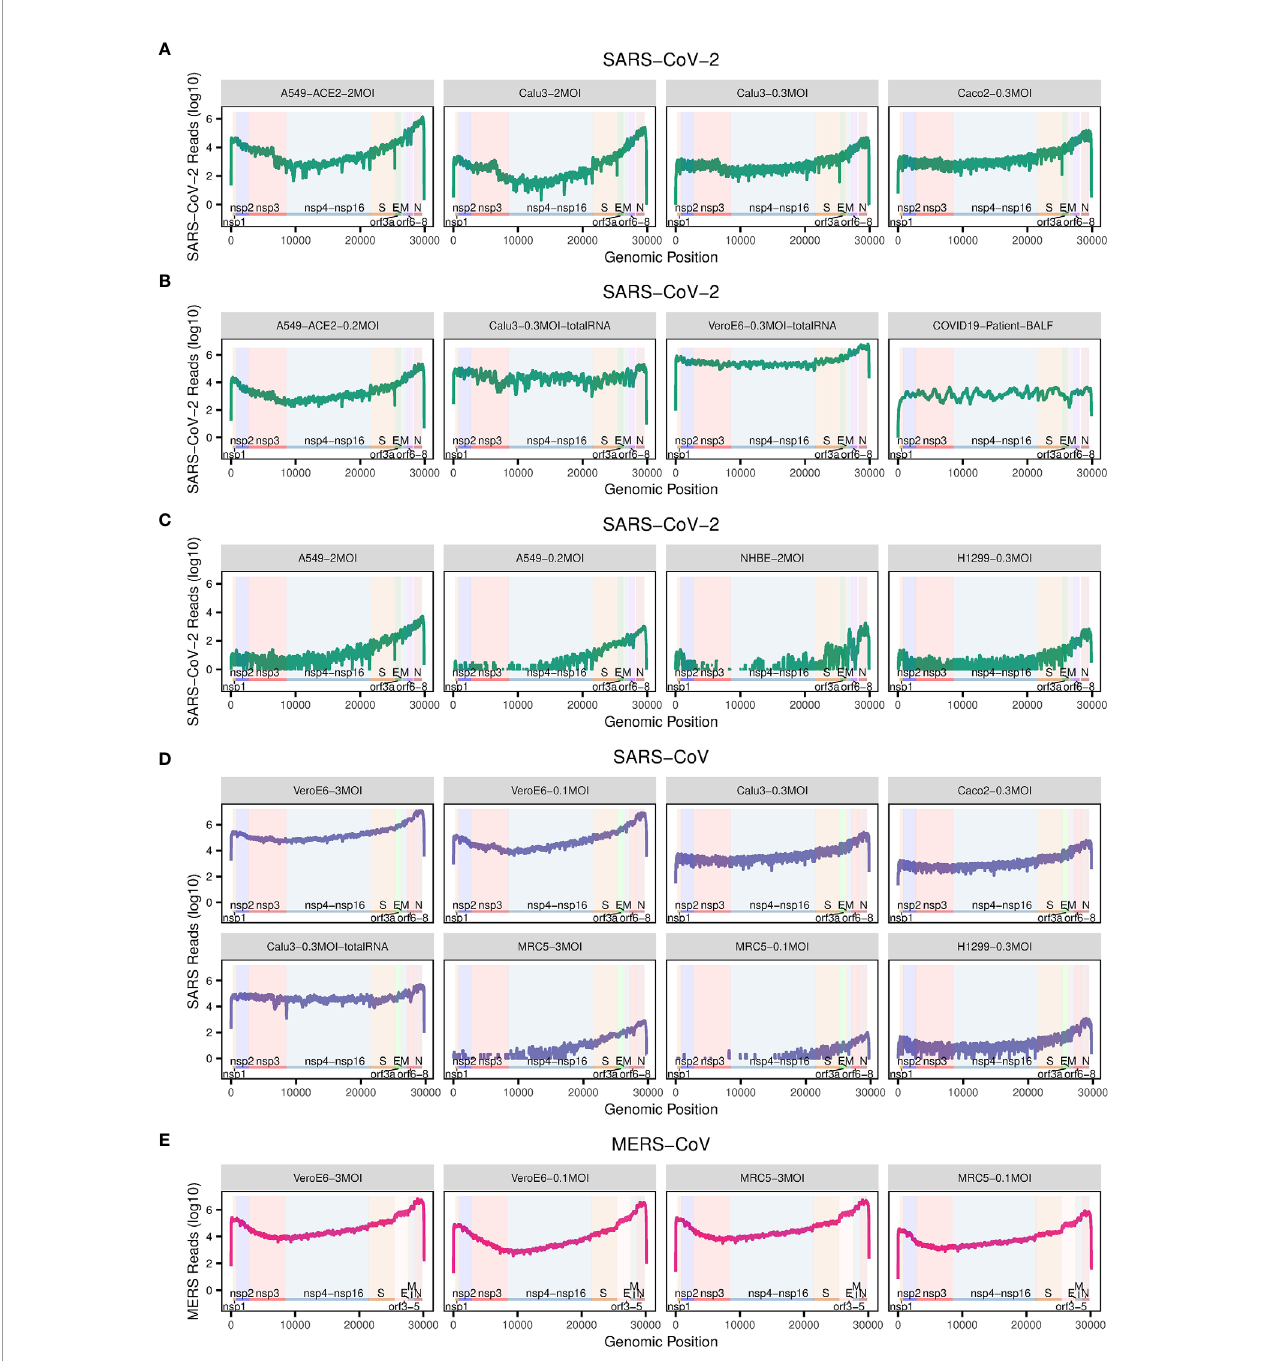
FIGURE 2 | The number of reads mapped to the corresponding virus genome. (A – E) The dot plots show the number of reads mapped to each site of the corresponding virus genome. The annotation of the genome of each virus is from NCBI (SARS: GCF_000864885.1, SARS-CoV-2: GCF_009858895.2, MERS: GCF_000901155.1). Labels in grey title bars correspond to conditions as in Figure 1